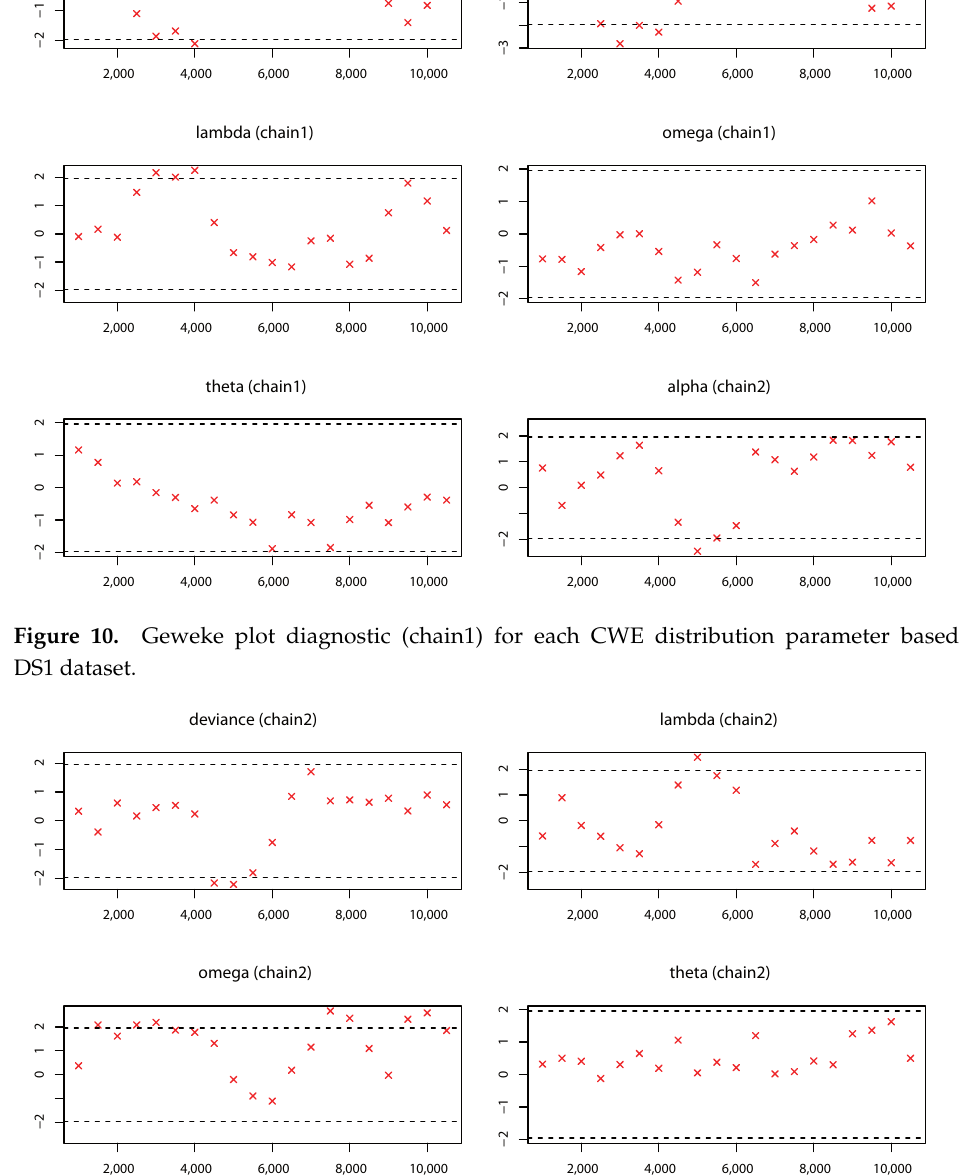
Figure 11. Geweke plot diagnostic (chain2) for each CWE distribution parameter based on DS1